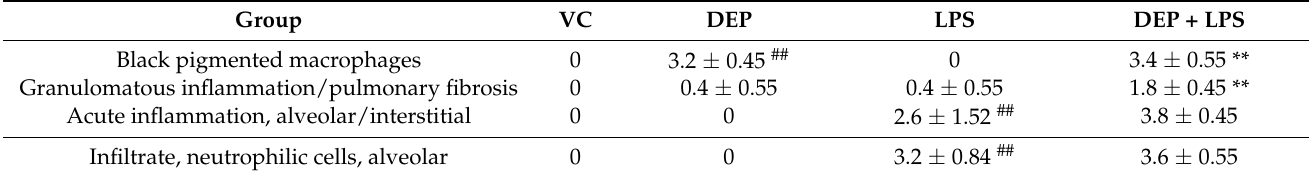
1: minimal; 2: slight; 3: moderate; 4: severe. Data are presented as means ± SD for five mice per group. DEP, diesel exhaust